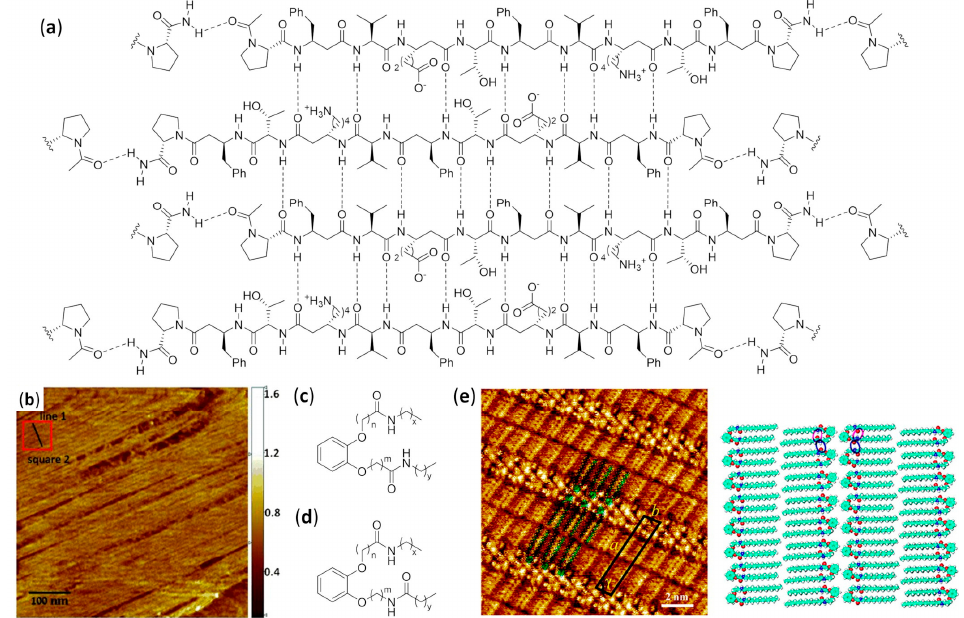
Figure 20. ( a ) Two-dimensional antiparallel arrangement of the amphiphilic oligomer β E β K within the monolayers at the air–water interface (hydrophilic side chains project into the aqueous phase below the plane, while hydrophobic side chains project into the air above the plane) (Refs. [221,222,224]); ( b ) AFM image of β E β K film transferred at 2.6 mN m − 1 onto mica (reprinted with permission from Ref. [224]; ( c ) and ( d ): general structures of catechol foldamers (Refs. [225–228]); ( e ) STM image of a physisorbed catechol derivative (n = 1, m = 3, x = 11, y = 12 in panel ( d )) at the 1-phenyloctane / HOPG interface (unit cell in black), and molecular model of its 2D pattern (intramolecular and intermolecular hydrogen bonds indicated by red and blue circles, respectively) (reprinted with permission from Ref. [227]).